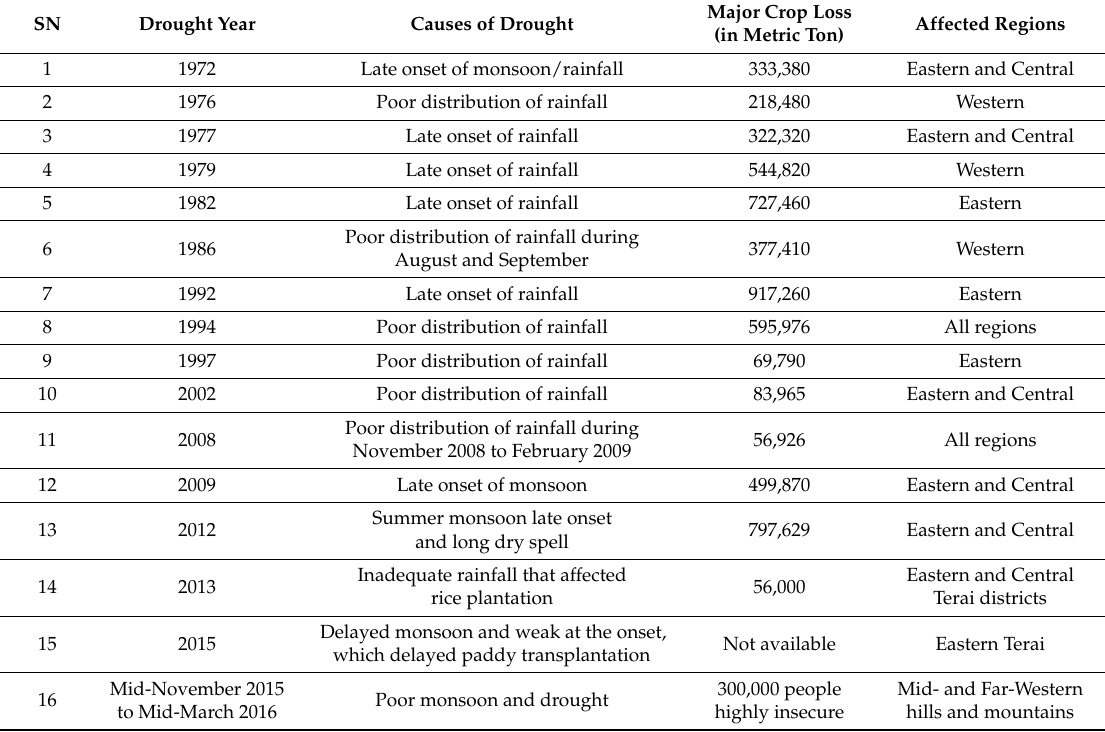
Table 1. Impact of drought on production of major crops in different years in